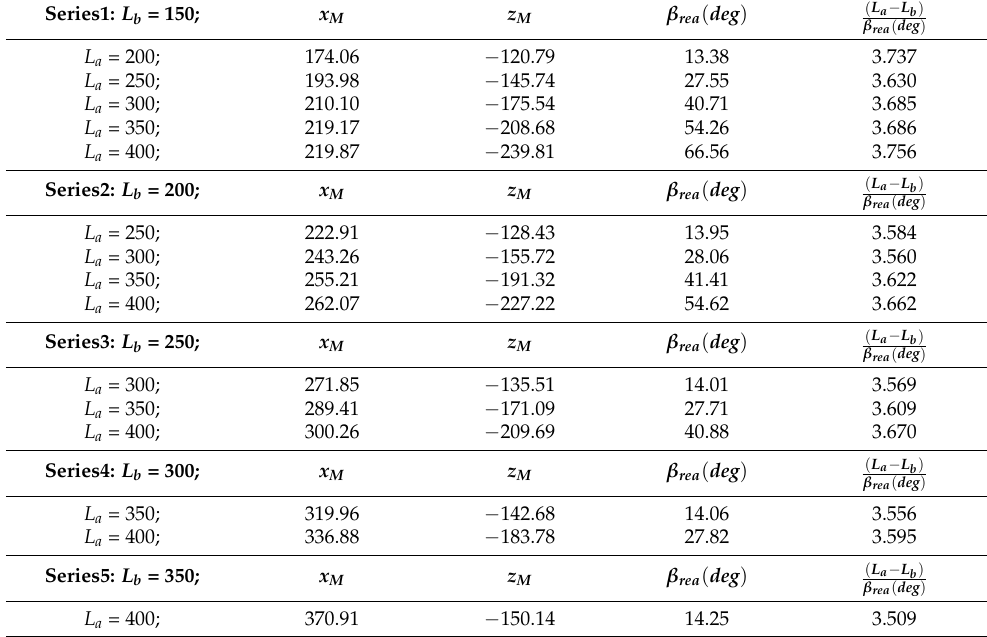
Table 1. Experimental results unit: mm.